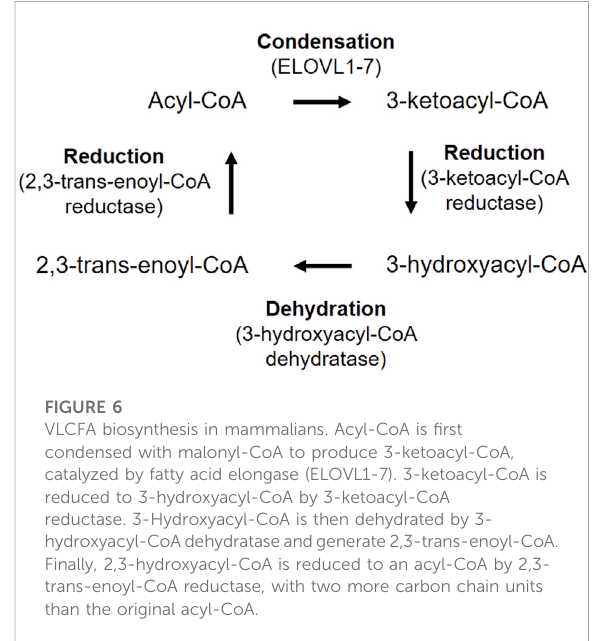
FIGURE 6 VLCFA biosynthesis in mammalians. Acyl-CoA is fi rst condensed with malonyl-CoA to produce 3-ketoacyl-CoA, catalyzed by fatty acid elongase (ELOVL1-7). 3-ketoacyl-CoA is reduced to 3-hydroxyacyl-CoA by 3-ketoacyl-CoA reductase. 3-Hydroxyacyl-CoA is then dehydrated by 3- hydroxyacyl-CoAdehydrataseandgenerate2,3-trans-enoyl-CoA. Finally, 2,3-hydroxyacyl-CoA is reduced to an acyl-CoA by 2,3- trans-enoyl-CoA reductase, with two more carbon chain units than the original